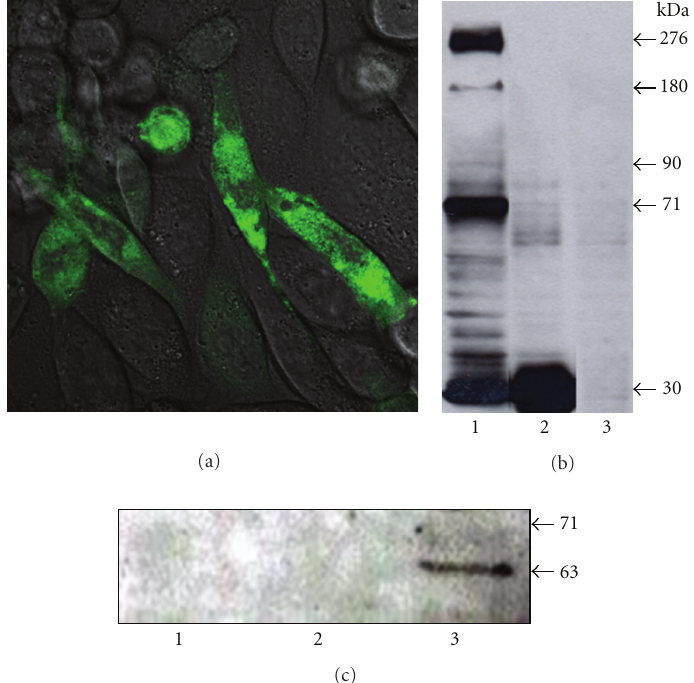
Figure 2: Expression analysis of recombinant GFP-GLP-1 receptor from CHO cells. (a) CHO cells expressing GFP-GLP-1 receptor are viewed under standard light conditions or under argon-ion laser light source (488nm) 24-hour posttransfection (merge pictures). (b) Western blot analysis with the anti-GFP primary polyclonal mouse IgG antibodies. Lane 1: membranes with the GFP-GLP-1 receptor; lane 2: membranes with the GFP; lane 3: membranes CHO. (c) Western blot analysis with the anti-GLP-1R primary polyclonal rabbit IgG antibodies. Lane 1: membranes CHO; lane 2: membranes with the GFP-GLP-1 receptor; lane 3: membranes with the GLP-1 receptor. The amount of protein loaded in each well in SDS-PAGE was 50 μ g.